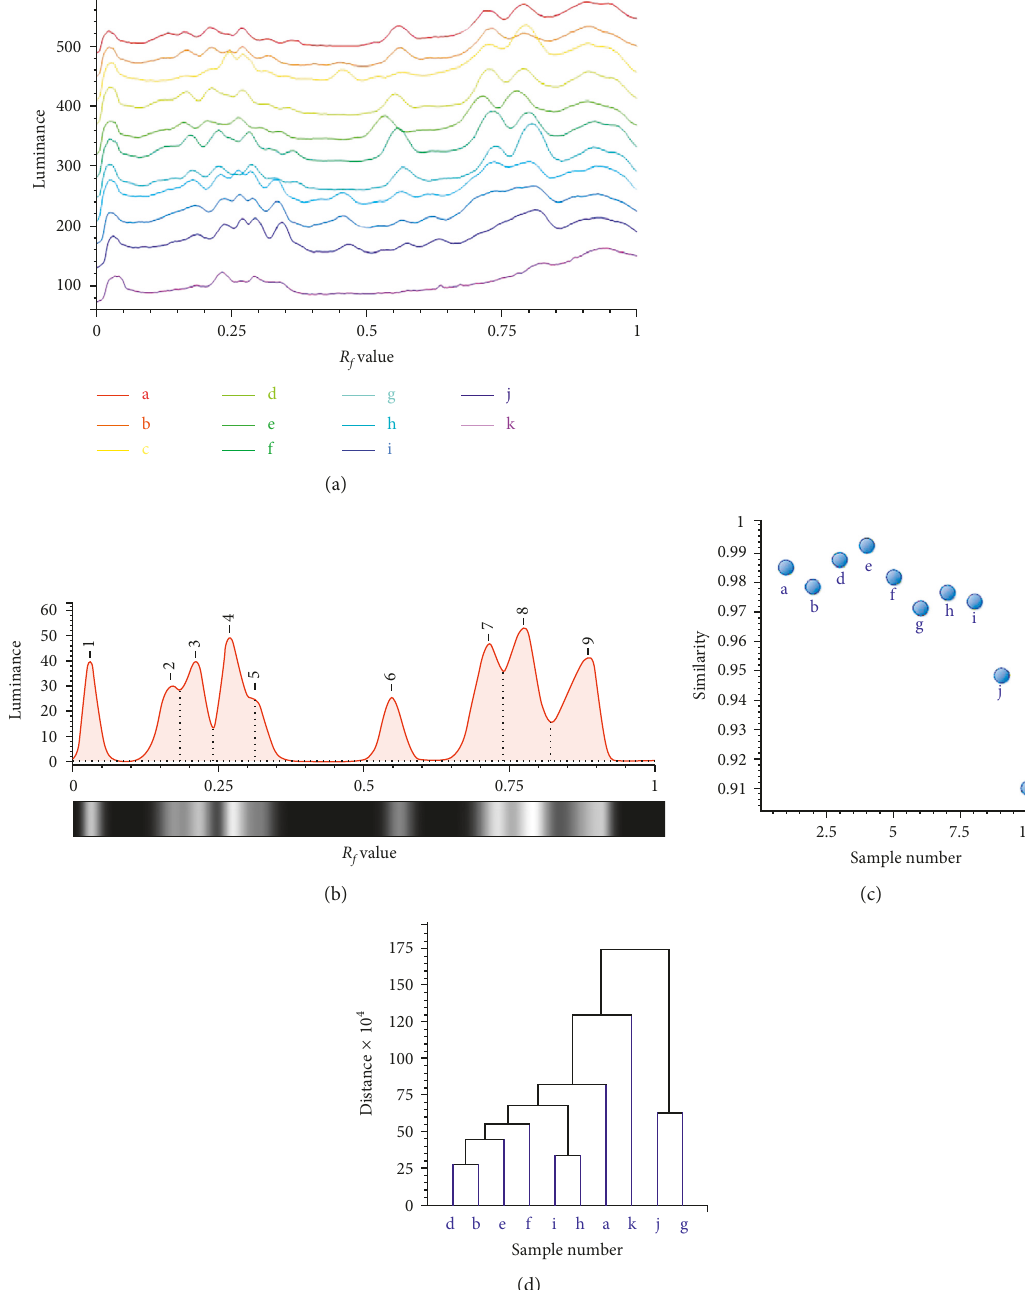
Figure 6: TLC fingerprints of triterpenoids obtained from different Ganoderma species (a) and their common pattern (b). The similarity analysis (c) and clustering analysis (d) of